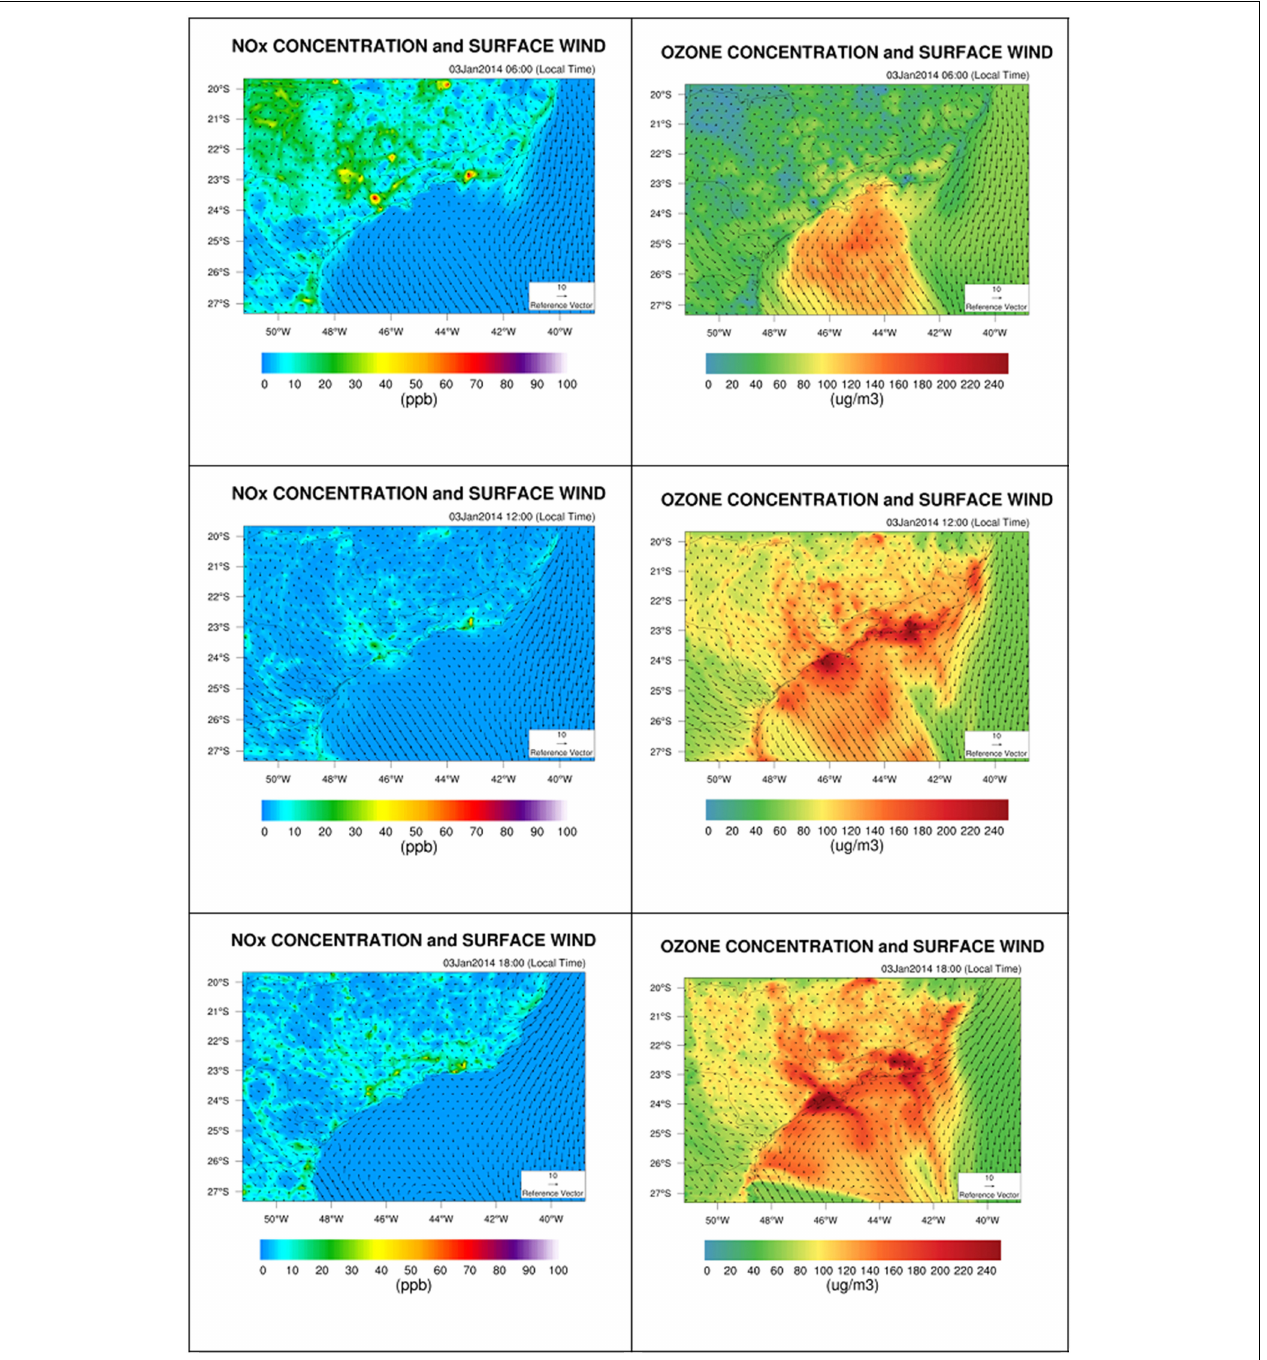
FIGURE 11 | Spatial distribution of NO x (left side) and ozone (right side), for the modeling area as a whole, at 6:00 a.m. (top), 12:00 p.m. (middle), and 6:00 p.m. (bottom) on January 3, 2014.